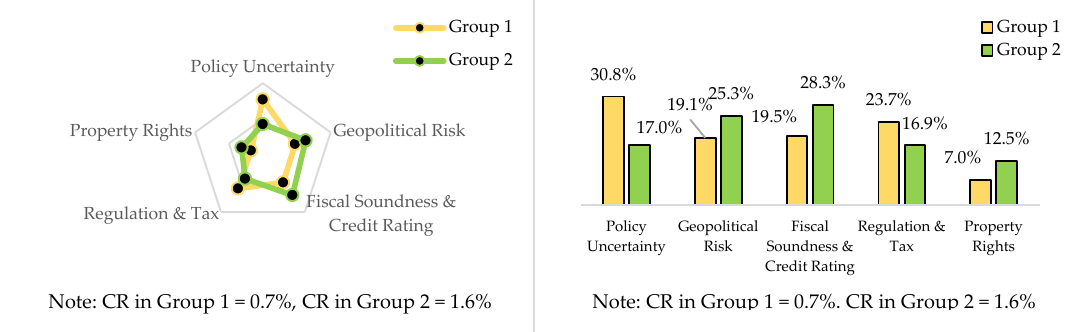
Figure 11. Local weights for risk factors between group 1 and group 2.